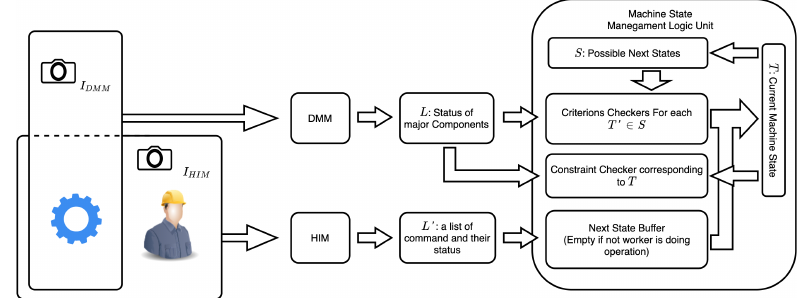
Figure 1. The framework of